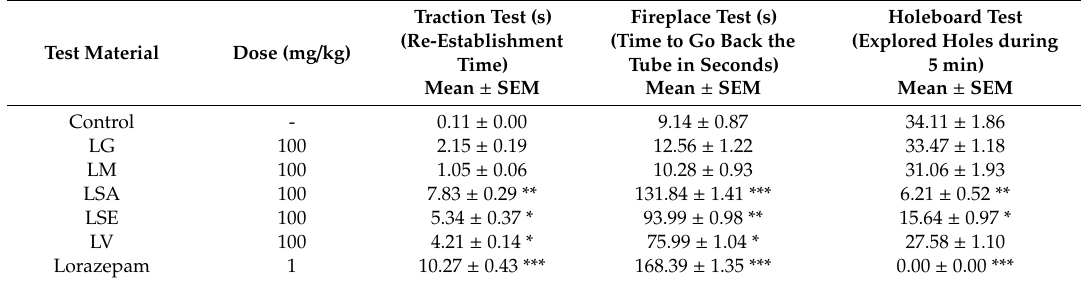
Table1. Sedativee ff ectsoftestmaterialsdeterminedbythetractiontest, fireplacetest, andholeboardtest.